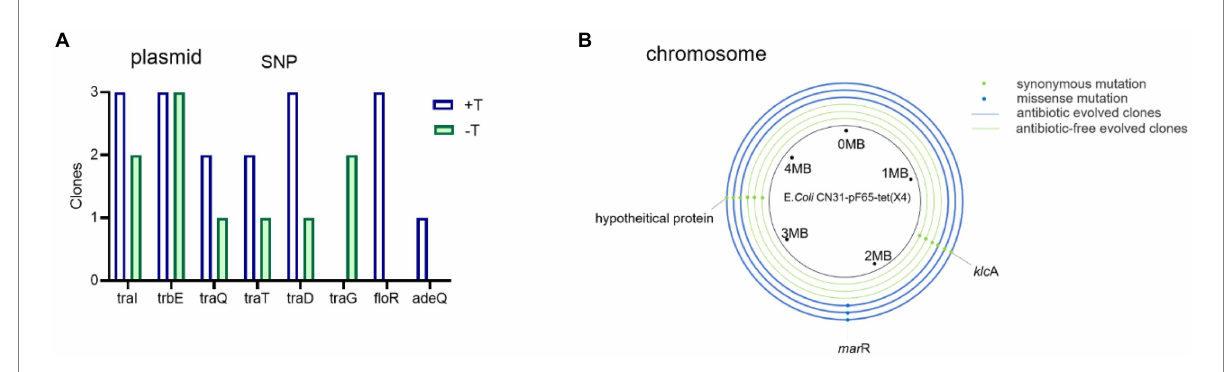
FIGURE 6 Genomic mutations associated with conjugative transfer-related genes and antibiotic resistance genes on plasmid and chromosome. (A) Mutations observed on plasmid of evolved clones. (B) Mutations observed on chromosome of evolved clones. Blue rings represent the antibiotic evolved clones and the green rings represent the antibiotic-free evolved clones. Dots represent the